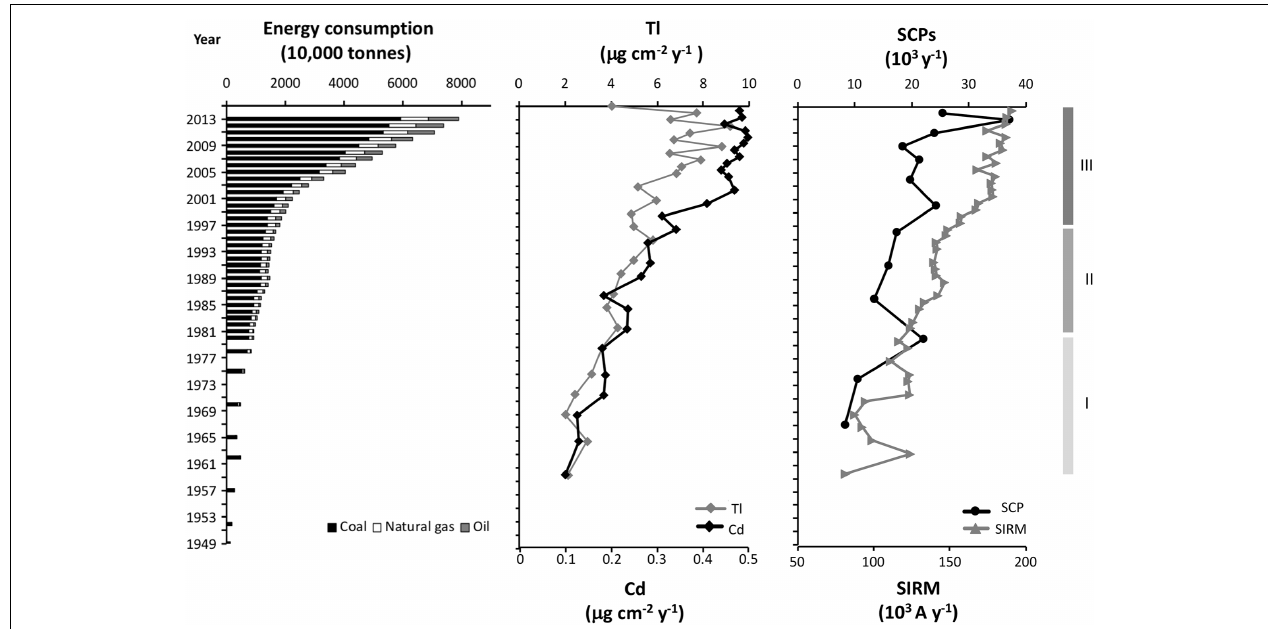
FIGURE 6 | Historical fuel consumption trends for Chongqing (Fumin and Zesheng, 2016) showing coal, natural gas and oil consumption from 1949 to 2013, plotted alongside pollution flux data from SKP (1960–2015). SIRM, a proxy for PM 10 and PM 2 . 5 pollution (Speak et al., 2012; Wang et al., 2017); SCPs, unambiguous indicator of fossil fuel combustion (Rose, 2015); Tl, a tracer for coal emissions (Vanˇek et al., 2016) and smelting (Karbowska, 2016); and Cd, a tracer for industry, smelting and coal combustion (Gao et al., 2013; Shi et al., 2018) are presented. Tl and Cd were selected as metals representative of anthropogenic enrichment ( Table 3 ). Flux trends mirror increases in coal, gas and oil consumption since 1960 and statistically significant correlations are observed ( Table 5 ).